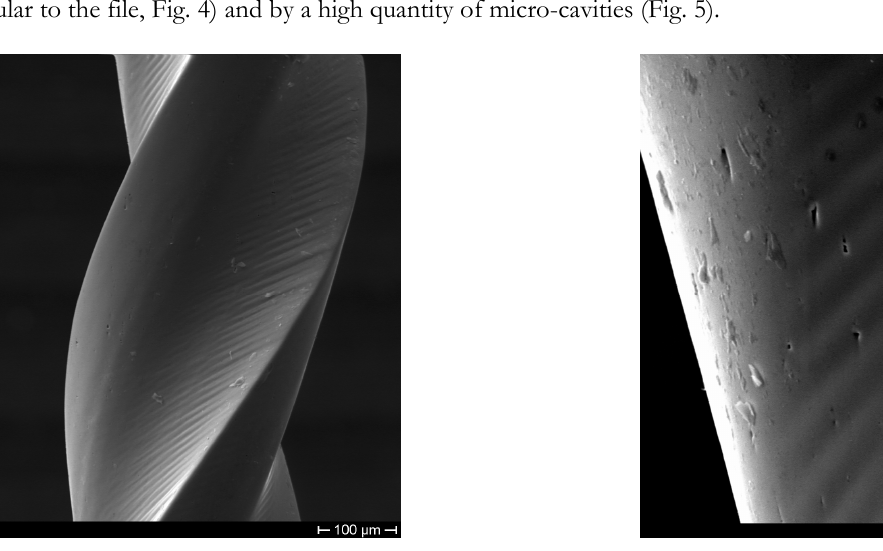
Figure 4: SEM micrograph of as received instruments surfaces. Figure 5: SEM micrograph of as received instruments surfaces.